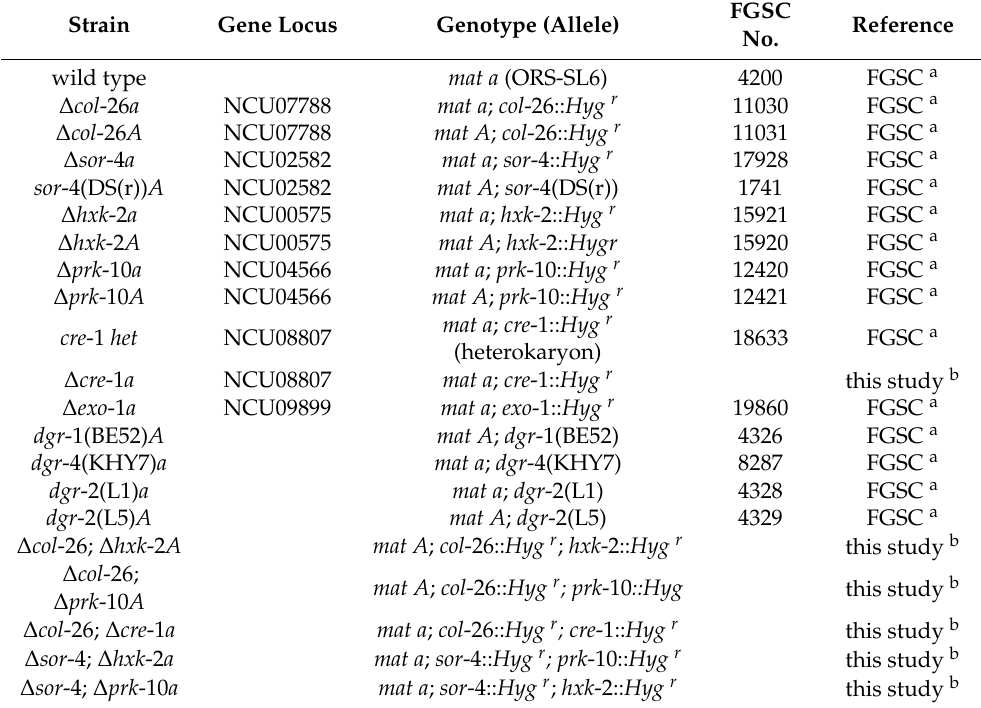
Table 1. Strain list used in this study. Strain Gene